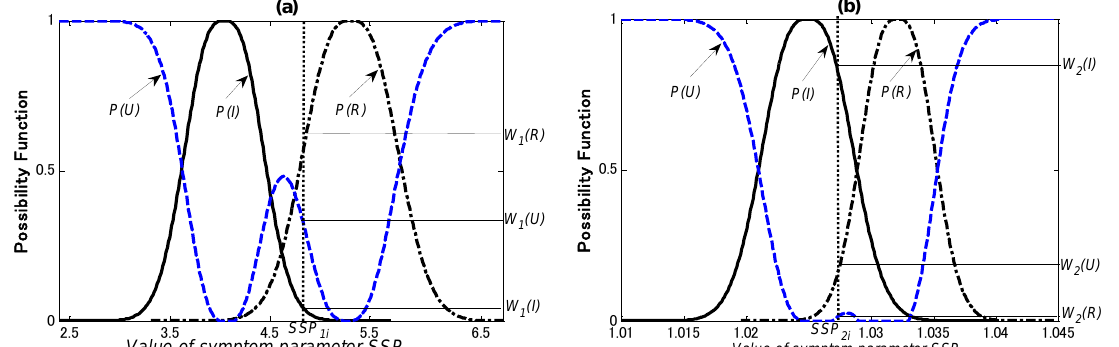
and ( b ) SSP for third diagnostic 1 2